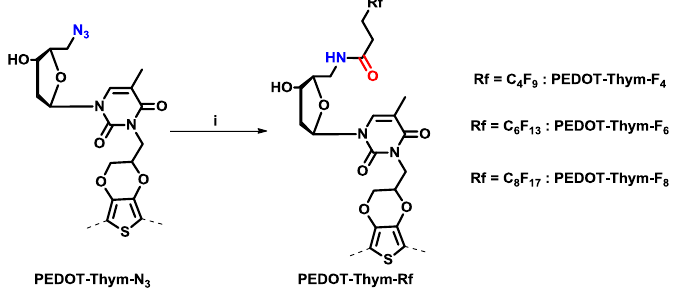
Figure 3. Global procedure for post-functionalization. ( i ) perfluorinated carboxylic acid, 1-ethyl-3-(3-dimethylaminopropyl)carbodiimide, N , N -dimethylaminopyridine, tributylphosphine, THF, rt, 3 h.